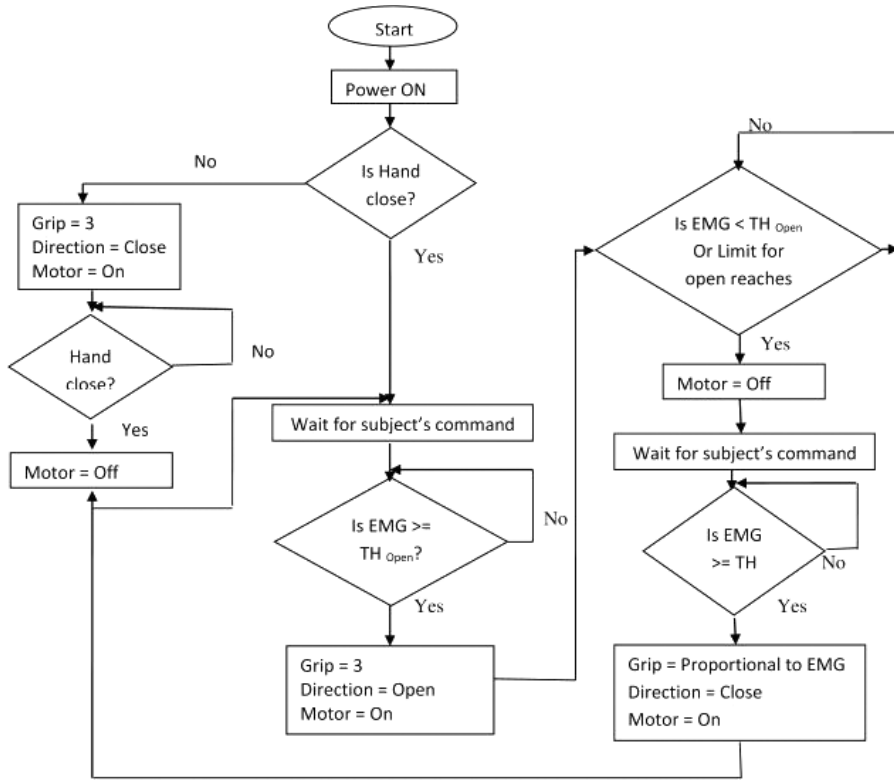
Fig. 2. Flow chart for the complete operation of myoelectric